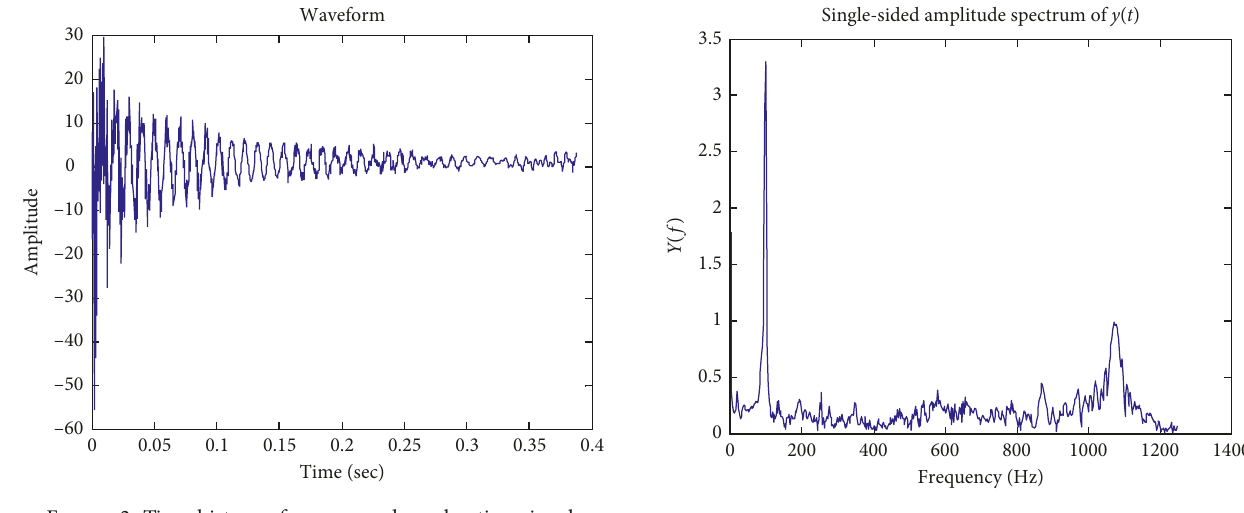
Figure 2: Time history of a measured acceleration signal. Figure 3: FFT of the vibration